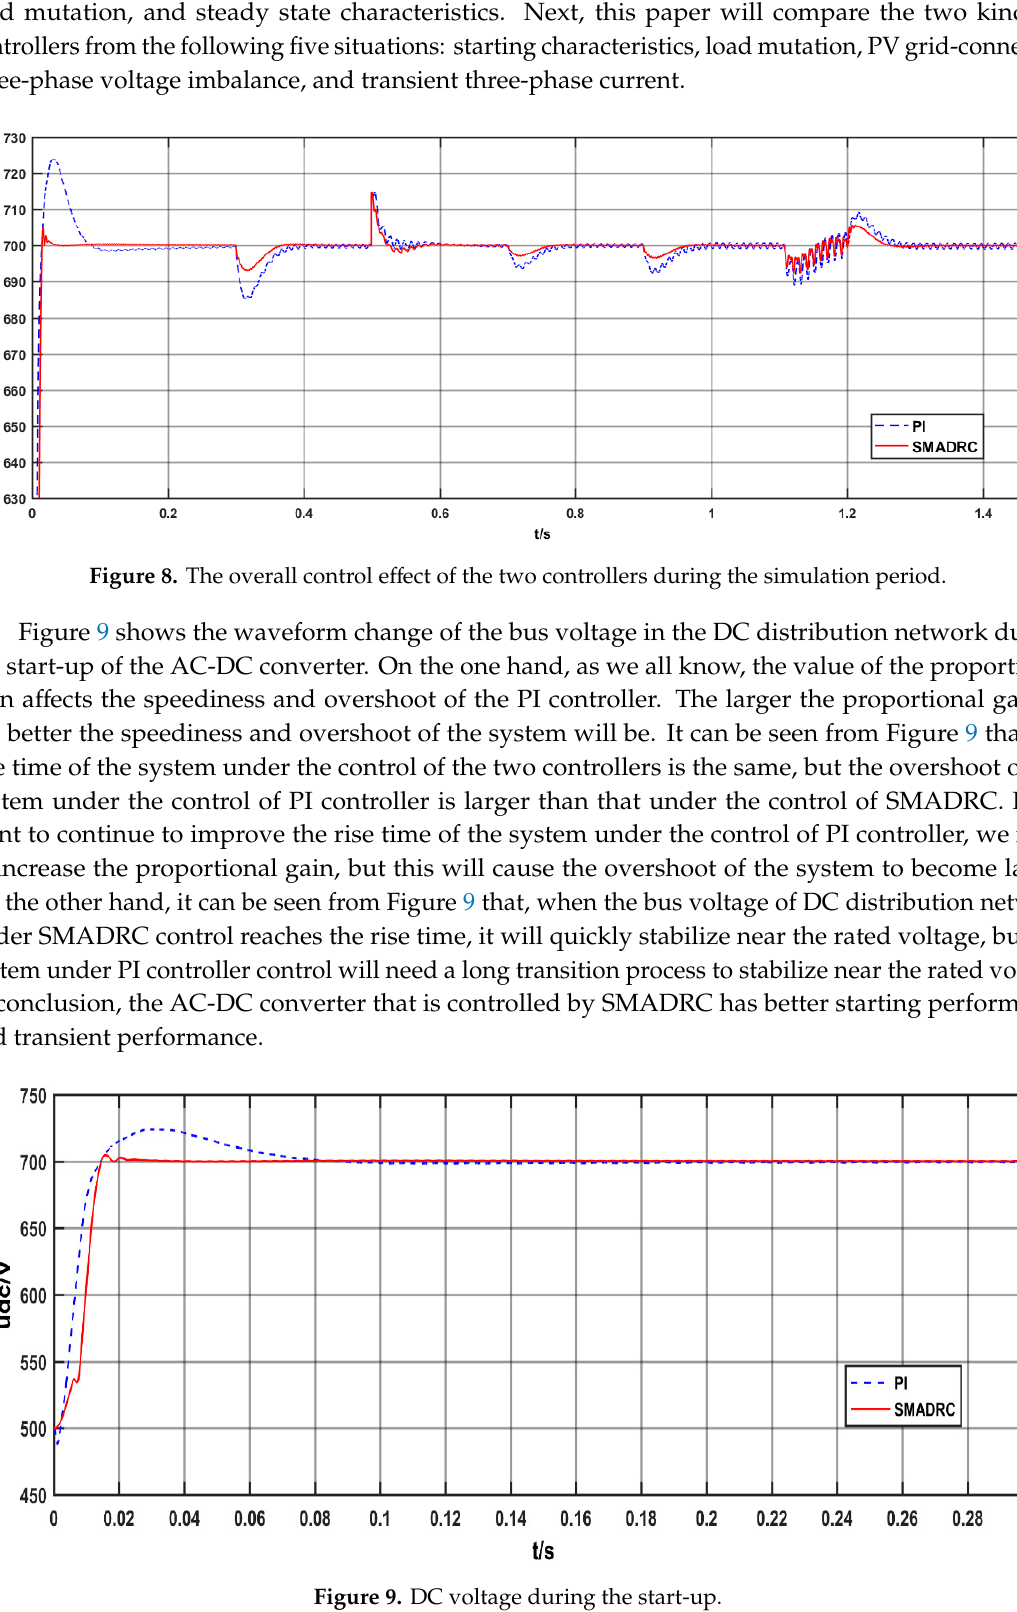
Figure 9. DC voltage during the start-up.